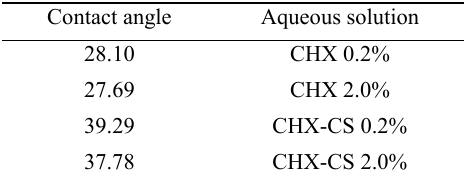
Table 1. Sessile drop contact angle of CHX-CS and CHX aqueous solutions